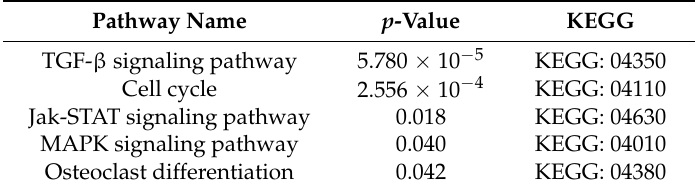
Table 1. Pathways significantly impacted during BMP7 stimulation in hTCEpi